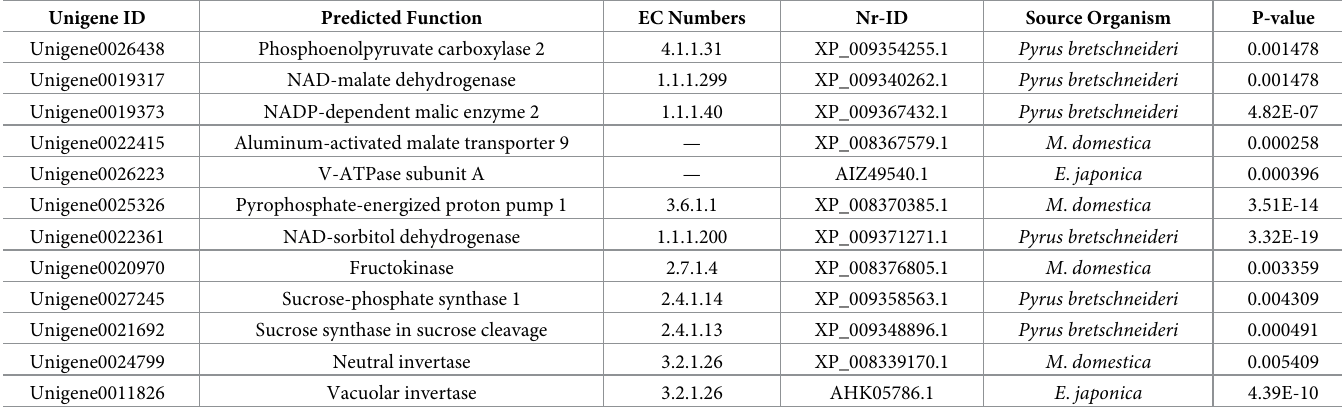
Table 3. List of 12 DEGs associated with fructose, sucrose, and malic acid metabolisms at 125 DAF. Unigene